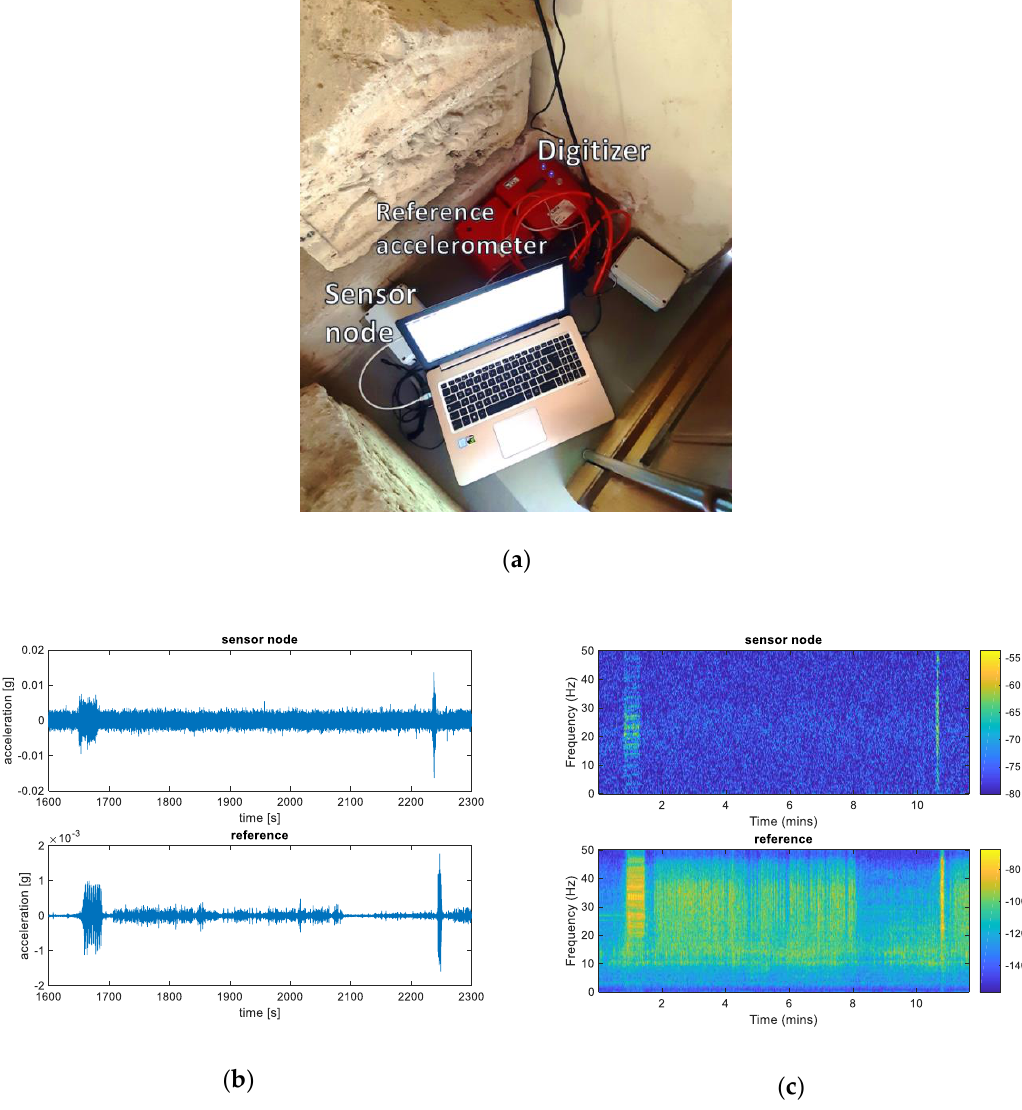
Figure 5. Experimental results from the field test: ( a ) photo of the set up in the museum building; ( b ) time domain plots of the x-axis acceleration; ( c ) spectrogram of the x-axis acceleration.